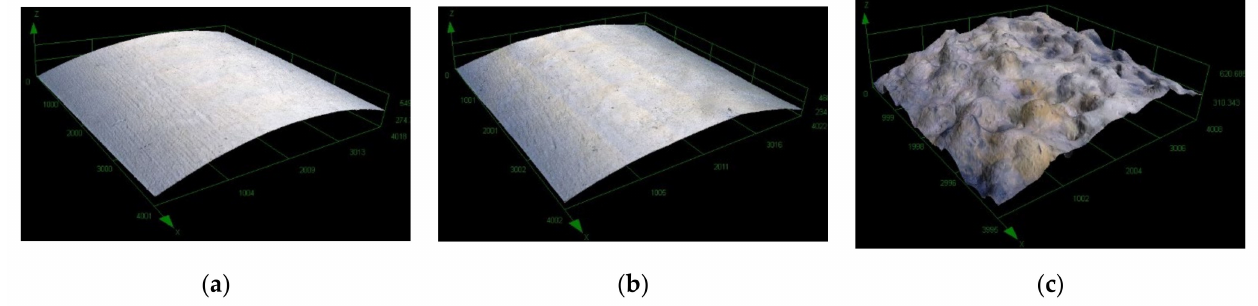
Figure 12. Profiles of metal rods with sintered powder: ( a ) nontreated and treated ( b ) for 5 min with air and ( c ) for 5 min with